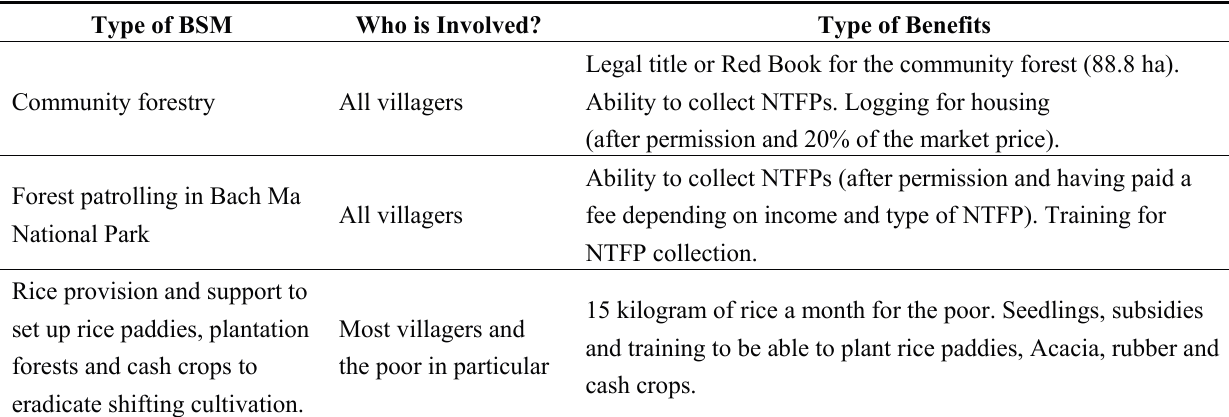
Table 4. Benefit sharing mechanisms in Thuong Nhat, Nam Dong District. Type of